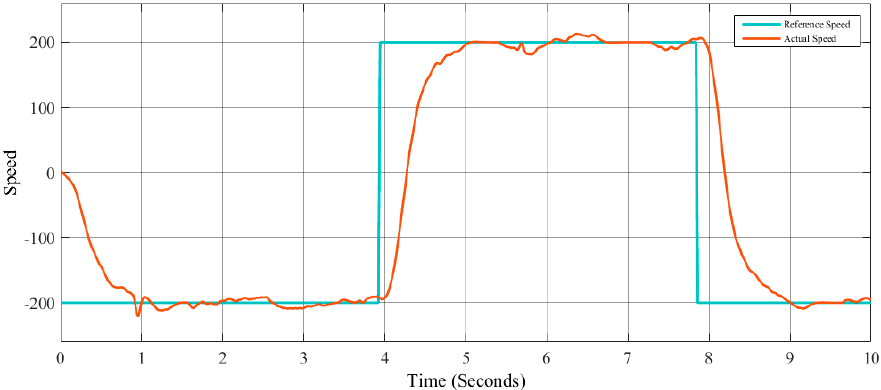
Figure 20. Simulation for PI controller.